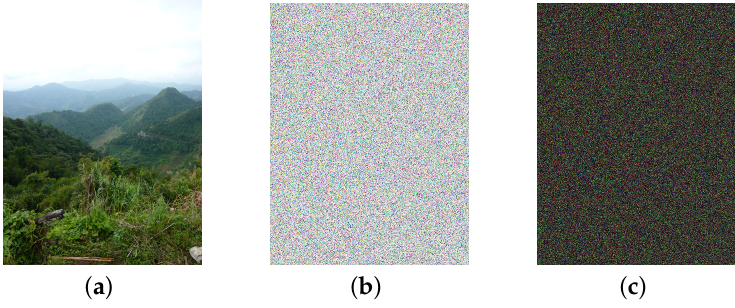
Figure 9. The encrypted results. ( a ) Original image; ( b ) Encrypted result of order difference; ( c ) Encrypted result of disorder difference.